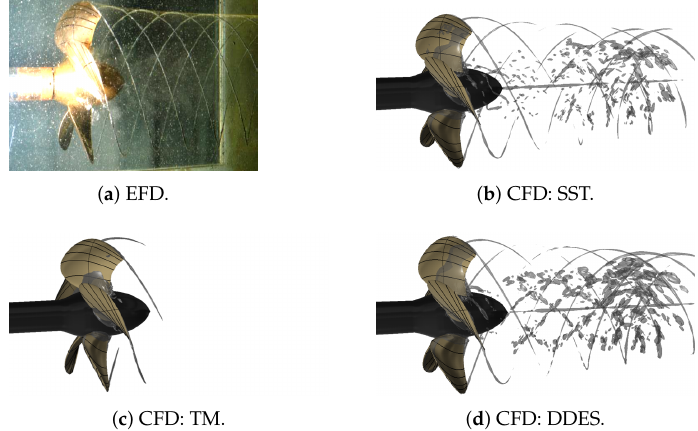
Figure 9. Comparison of model-scale cavitation patterns for the PPTC Case 2. The photograph from experiments is given in [26], and reproduced with permission from Lars Lübke